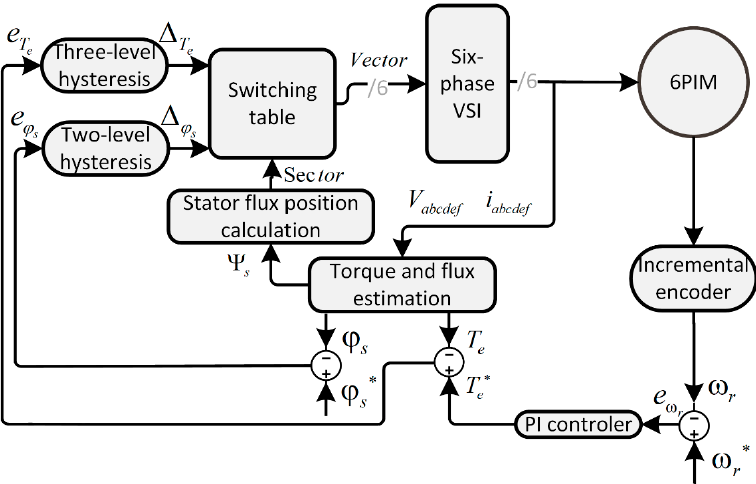
Figure 2. Conventional DTC block diagram.